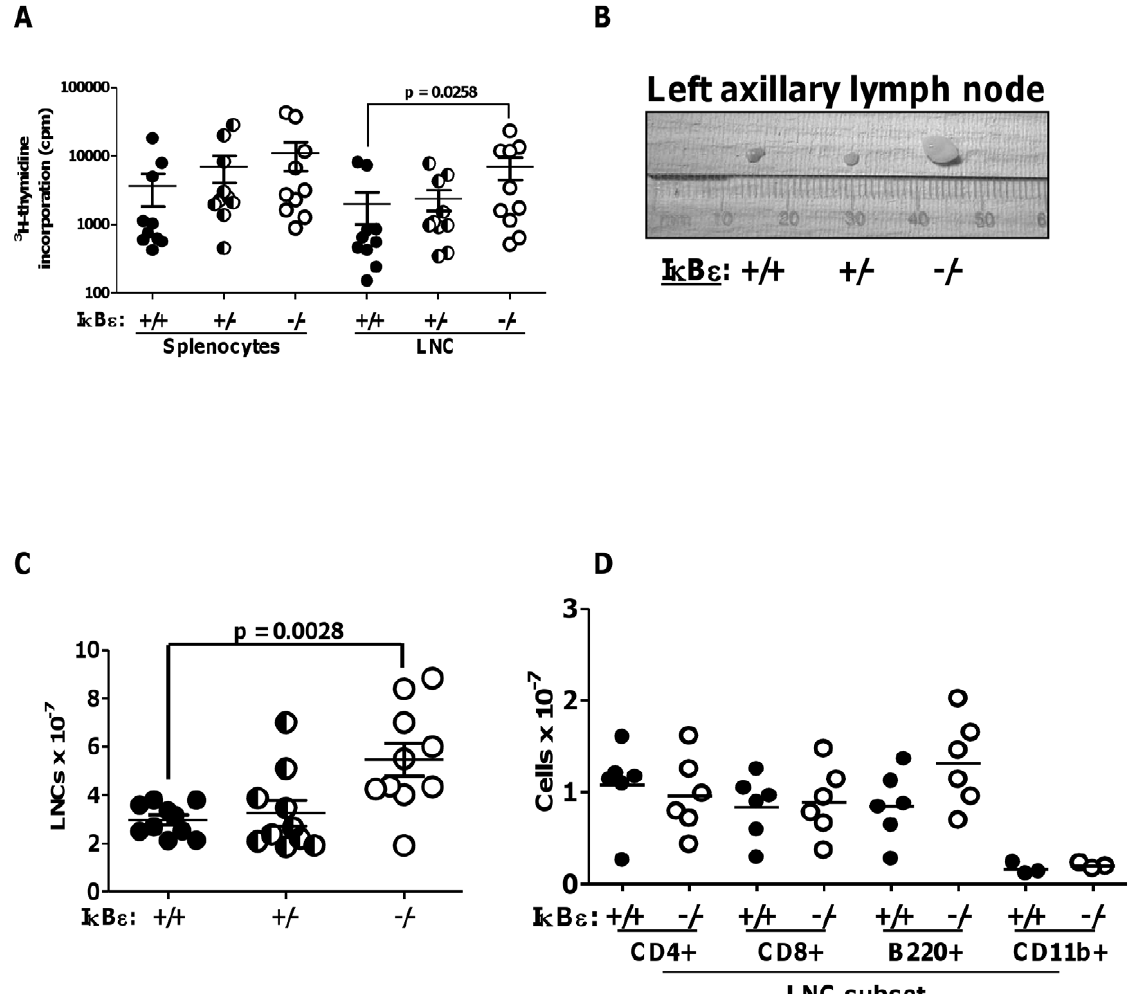
Figure 6. Increased basal thymidine uptake in splenocytes and LNC, increased LN cellularity and B cell numbers in I k B e 2 / 2 mice. (A) Basal thymidine uptake by splenocytes and LNCs in I k B e + / + , + / 2 and 2 / 2 mice (median, n=10 experiments). (B) Enlarged axillary lymph node from an I k B e 2 / 2 mouse compared to those from I k B e + / + and I k B e + / 2 . (C) Total lymph node cell numbers, one mouse per I k B e genotype per experiment (mean + / 2 SEM, n=10). (D) LNC were labelled with anti-CD4-PECy7, anti-CD8-PE, anti-B220-FITC and anti-CD11b-APC before flow cytometric analysis. The percentage of each cell subset was multiplied by the total LNC number to give numbers for each cell subset (mean, n=6 experiments).